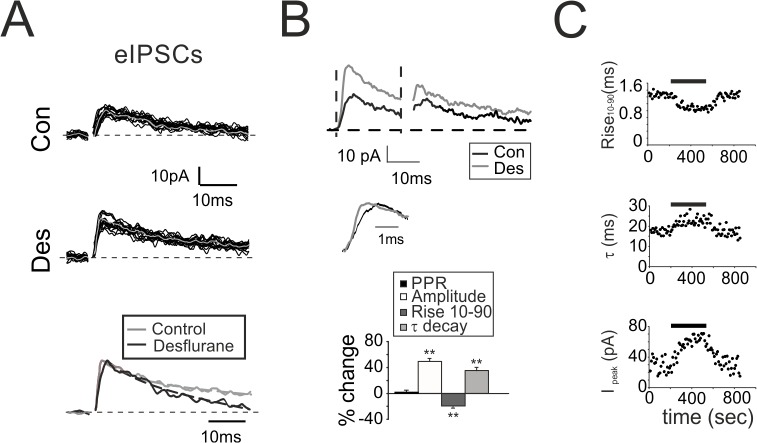
Modulation of evoked GABAergic inhibition by desflurane.
A. Evoked IPSCs elicited by a single stimulus before (Con) and during desflurane (Des). Gray traces indicate the average of the 15 superimposed traces. Bottom: Normalized average traces taken from upper panels. Monoexponential fitting (dashed lines) show the decreased rise and the increased decay time B. eIPSCs elicited by a pair of stimuli at 50Hz recorded from a different granule cell before (black) and during (gray) desflurane perfusion. Middle: rise time. Histogram summarizes the variations induced by desflurane on eIPSC biophysical properties (n = 7). C. Time courses of the effect of desflurane (bar) on eIPSCs rise time (Rise10–90), decay time constant (τ) and peak amplitude (Ipeak). Note the rapid effect onset (less than 30 sec). Steady state is obtained in less than 100 seconds.